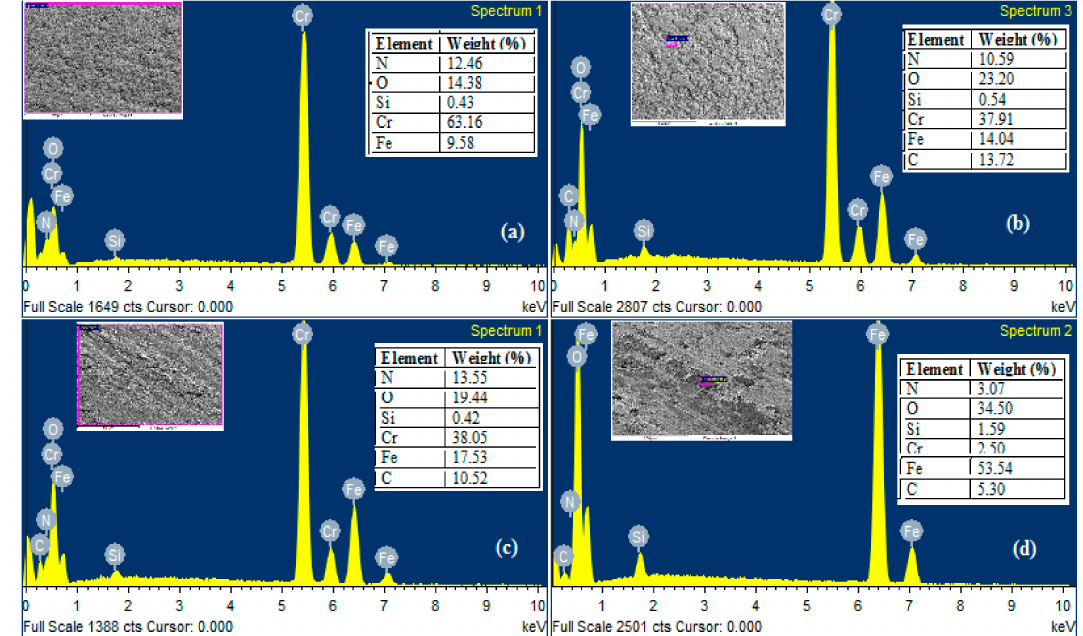
Figure 10. EDS spectra of wear track: ( a ) wear track at 28 ◦ C, ( b ) wear track at 100 ◦ C, ( c ) wear track at 200 ◦ C, ( d ) wear track at 300 ◦